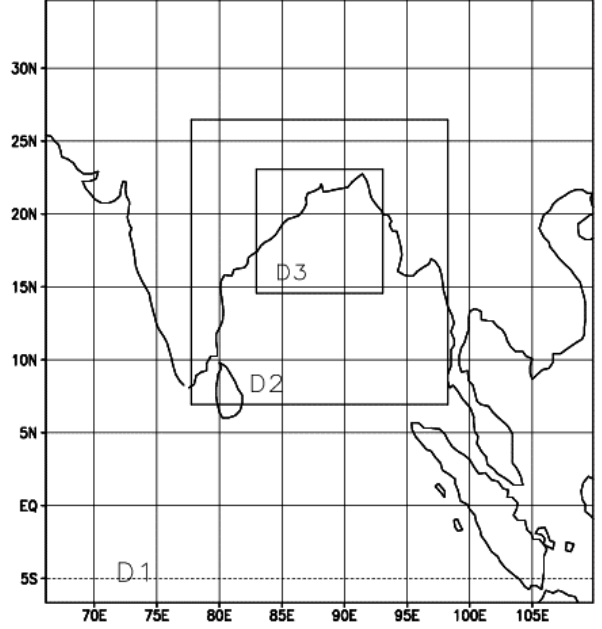
Fig. 1. Model domains configuration for numerical simulation ex- periments of Orissa super cyclone